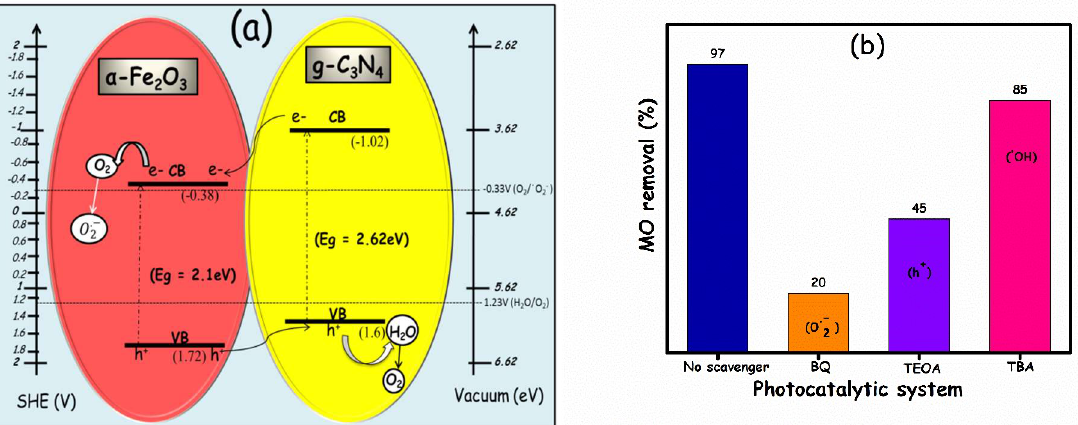
Figure 9. ( a ) Alignment of energy levels in the g-C 3 N 4 /α-Fe 2 O 3 nanocomposite. ( b ) Role of radical scavengers on MO photodegradation over g-C 3 N 4 /α-Fe 2 O 3